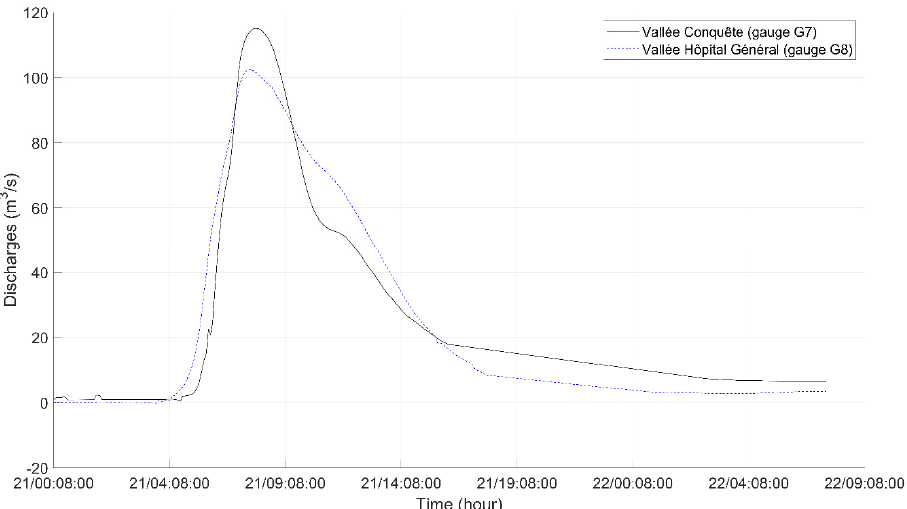
Figure 2. Hydrographs at “Vallée La Conquête” and “Vallée Hôpital Général” used as boundary conditions in the 2D HEC-RAS model.